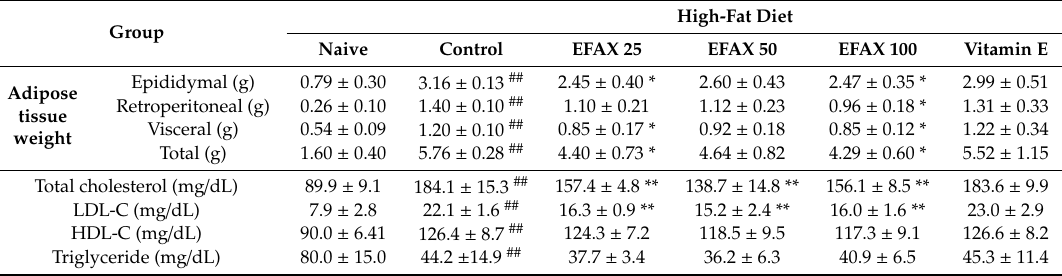
Figure 1. Effects on body weight, liver weight, and food (and calorie) intake. Mice (n = 8 in each group) were fed a 60% high-fat diet for 8 weeks, excluding the naive group (normal chow diet). From the 3rd week of high-fat diet feeding, distilled water (control), ethyl acetate fraction of Amomum xanthioides (EFAX) (25 mg/kg, 50 mg/kg, 100 mg/kg), and vitamin E (100 mg/kg) were administered by gavage daily for the last 6 weeks. Body weight ( A ), liver weight ( B ), and food intake ( C ) were recorded, and then caloric intake ( D ) was calculated. # p < 0.05, ## p < 0.01 compared with the naive group; * p < 0.05, ** p < 0.01 compared with the control group. Table 1. Adipose tissue weights and serum lipid profiles.